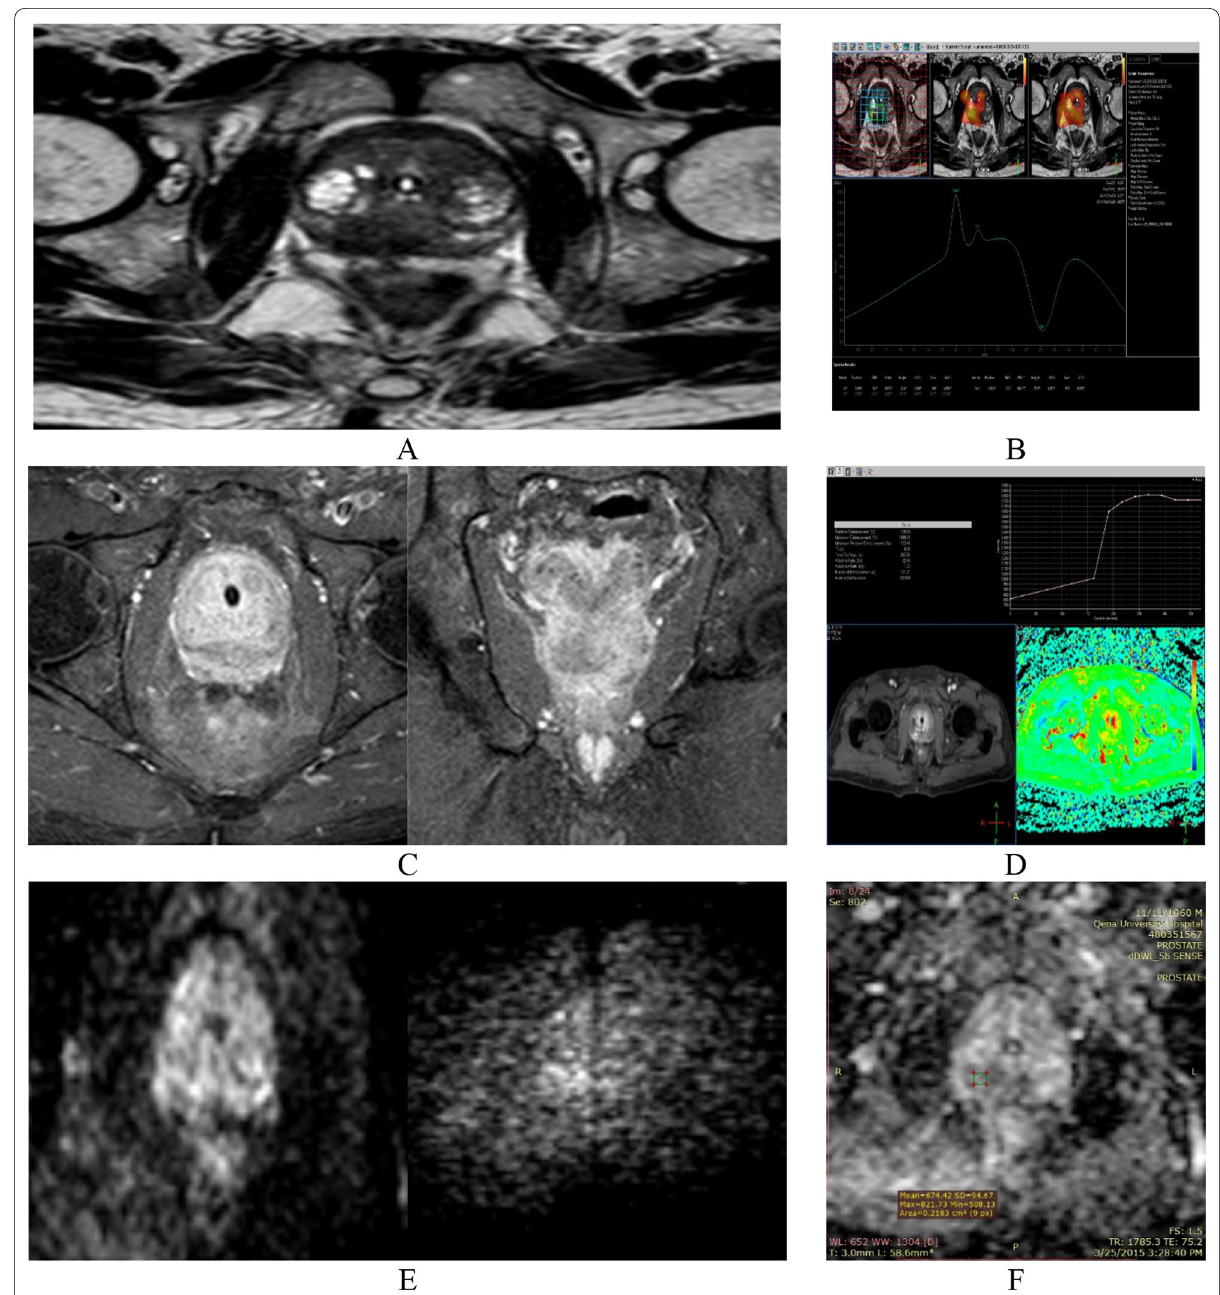
Fig. 2 67-year-old male patient presented with haemospermia and dysuria. A: Axial T2 Hypointense focal lesion in the PZ of Rt lobe with NV infiltration. B: MRS reveals Cho Cr/Cit ratio is high 86 ( ve for malignancy). C: Post GD contrast: shows Heterogeneous enhancement. D: DCE + + shows plateau curve. E and F: DWI Restricted at (at b500 and b1000 values free at b 1500) and (ADC mean